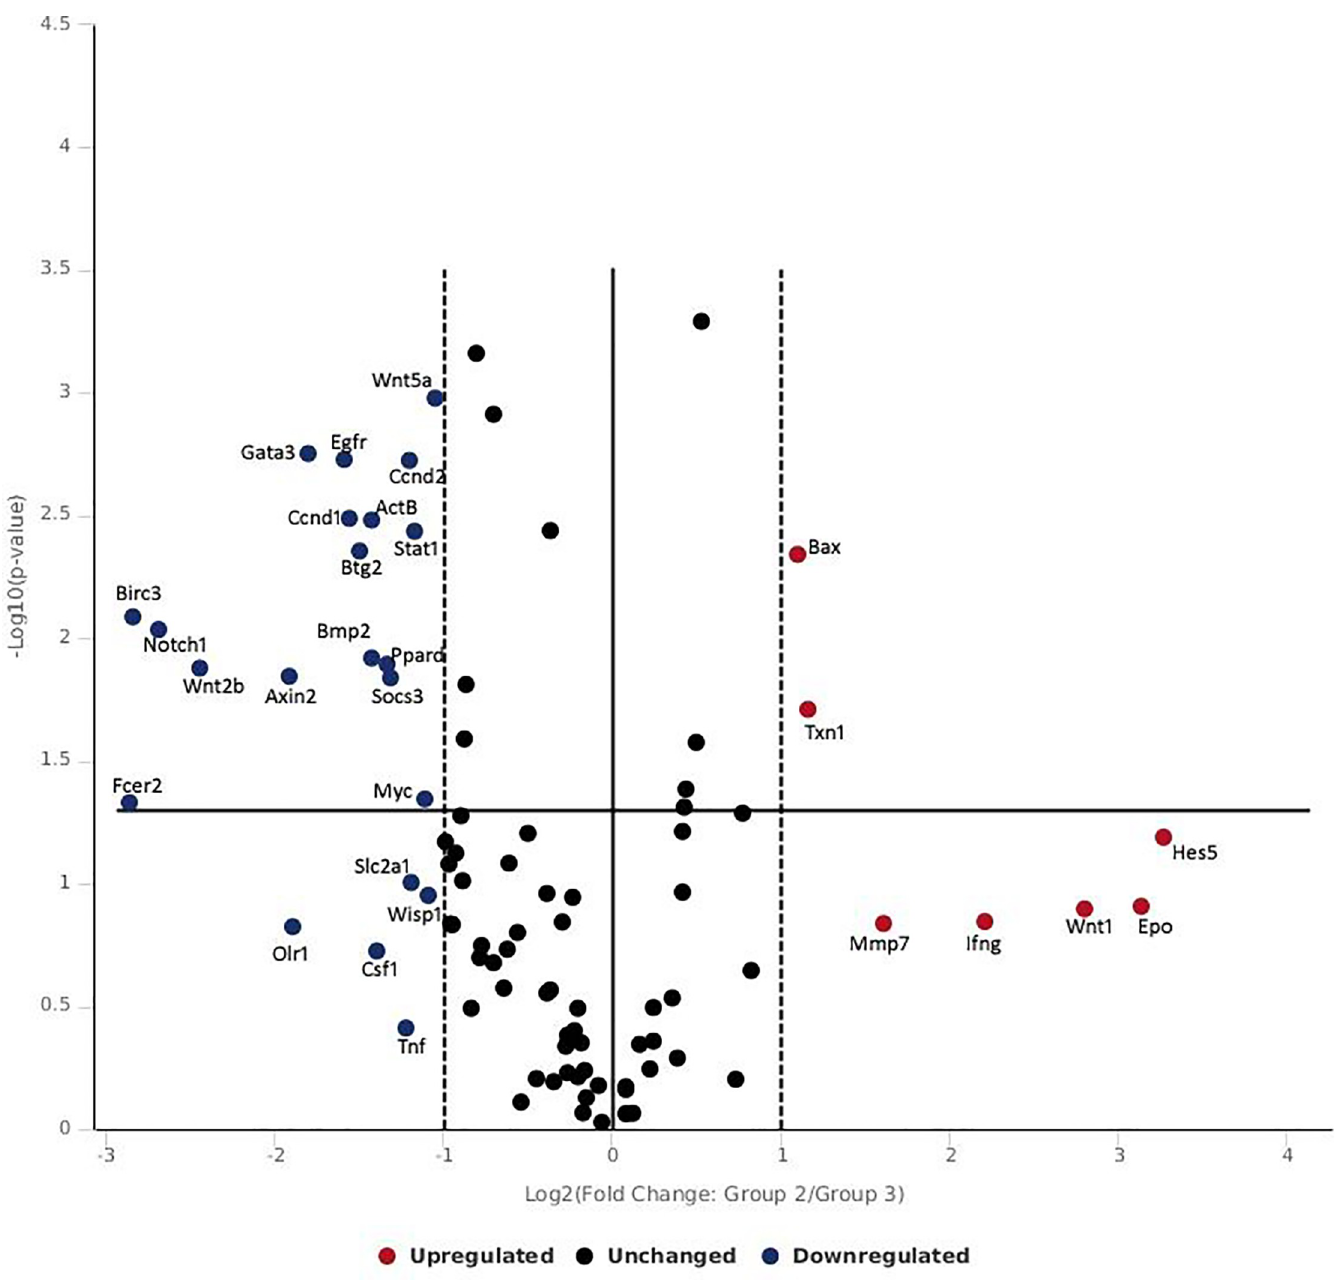
Fig 8. Volcano plot of intergroup comparison of genes expressed following 532 nm laser exposure at moderate irradiance (0.25 W/cm 2 ) and high irradiance (0.50 W/cm 2 ).